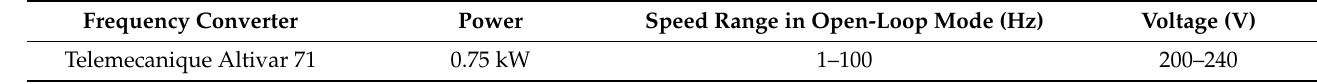
Table A3. Characteristic of the frequency converter used in this